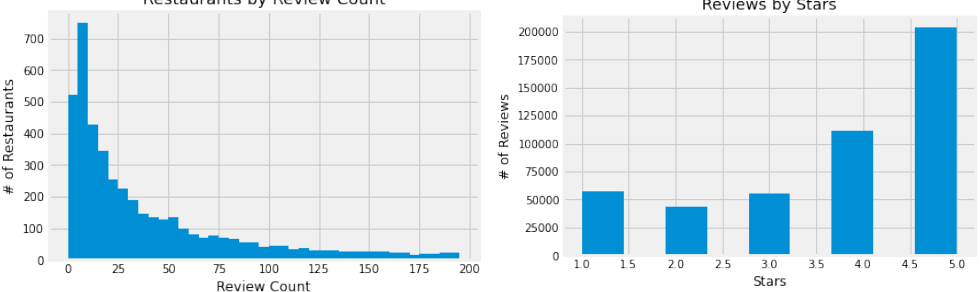
Figure 2. Reviews count in restaurants and stars count in reviews. Figure 3 represents the star rating distribution among restaurants and their counts.